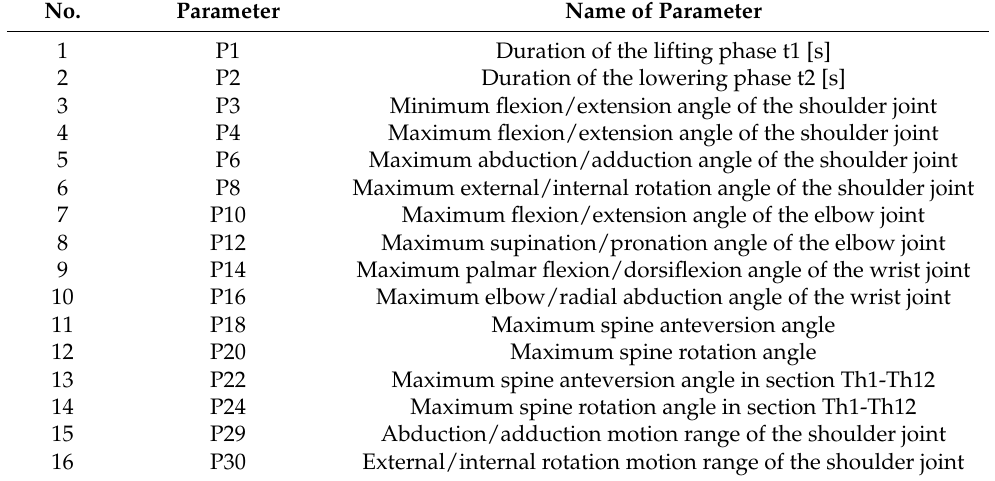
Table 8. Input parameters selected for the development of the Upper Body Index indicator.